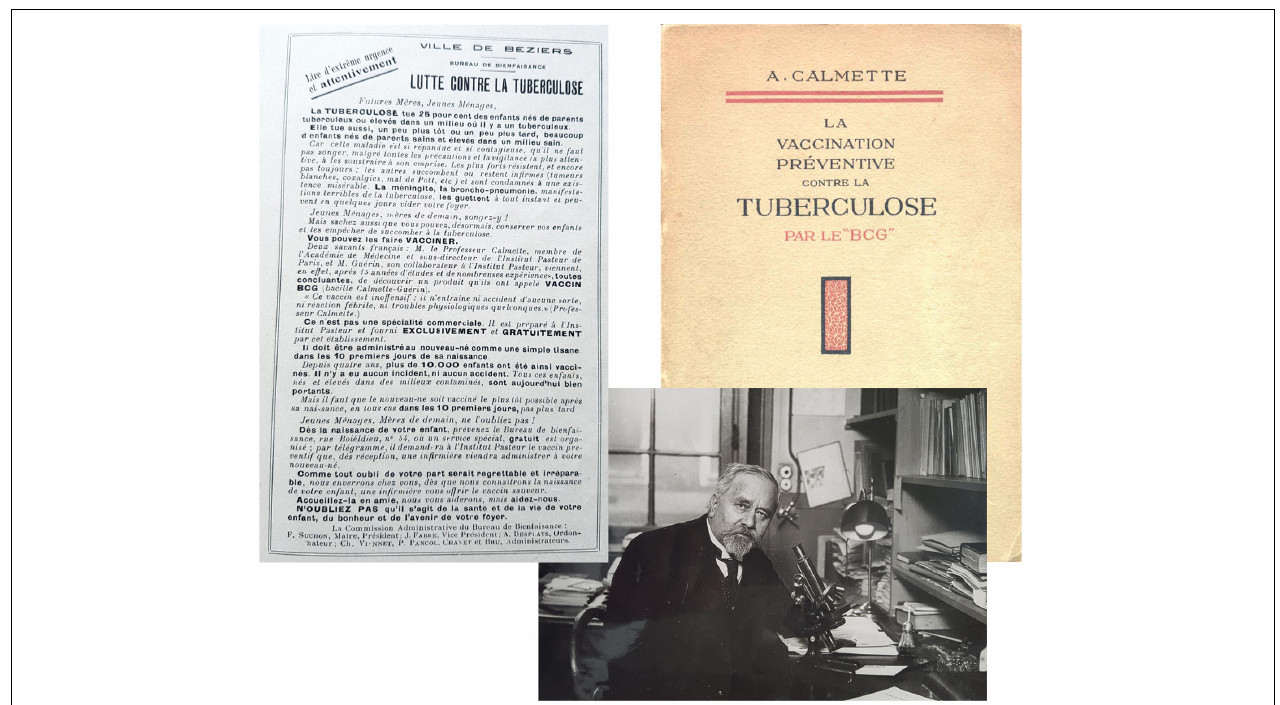
FIGURE 4 | Description of development and clinical testing of BCG. Figure shows title page of book, photo of the author, Albert Calmette, and leaflet advocating BCG vaccination of neonates from the book (Calmette et al.,